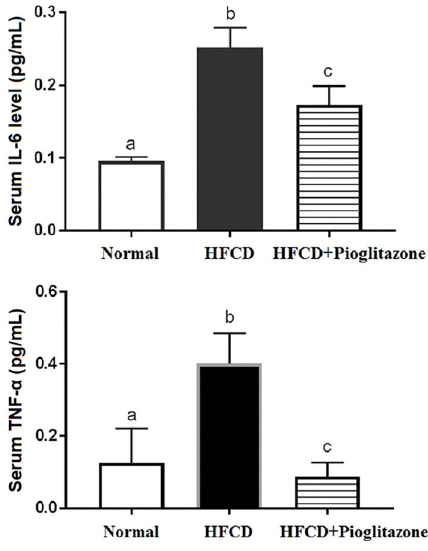
Figures 5. Role of high fat-carbohydrate diet (HFCD) and HFCD + pioglitazone on in fl ammatory markers interleukin-6 (IL-6) and tumor necrotic factor (TNF- a ). Data are reported as mean ± SE. Different letters indicate a statistical difference among groups (P o 0.05,